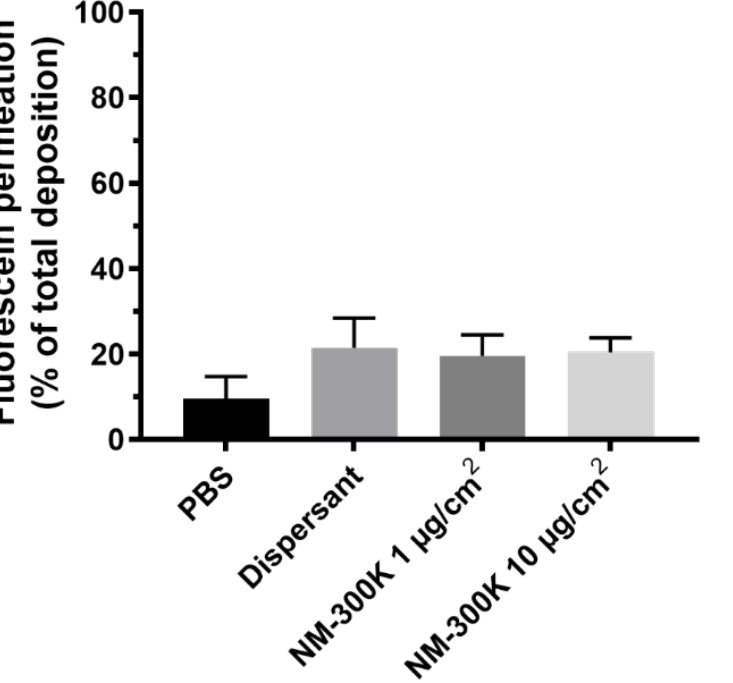
Figure 4. Permeation of fluorescein through the cellular layers. Shown is mean recovery of fluorescein ± SD in the basolateral compartment relative to the total deposition of fluorescein at the apical side of the membrane after exposure of cocultures in the cloud system to phosphate buffered saline (PBS), dispersant NM-300K DIS, or NM-300K at 1 or 10 µ g/cm 2 . The results are based on 4 technical replicates in n = 3 independent experiments. No statistically significant difference was seen between PBS treatment and the other samples, analyzed by ordinary one-way ANOVA with multiple comparisons, post-test Dunnett’s, p > 0.05. SD: standard deviation.